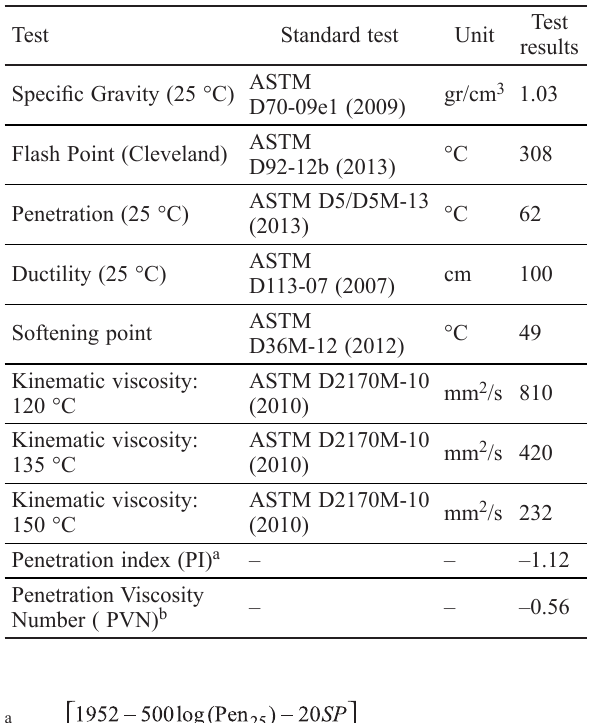
Table 1. Physical properties of the base bitumen